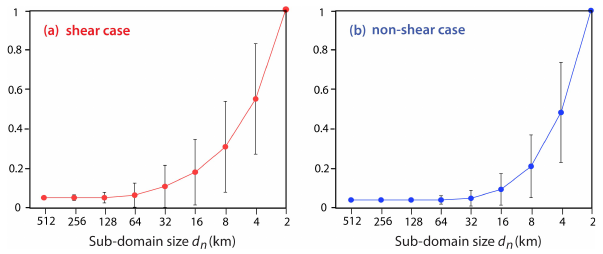
Fig. 8. Dependence of the mean fractional cloud cover at 3km height on the sub-domain size and its standard